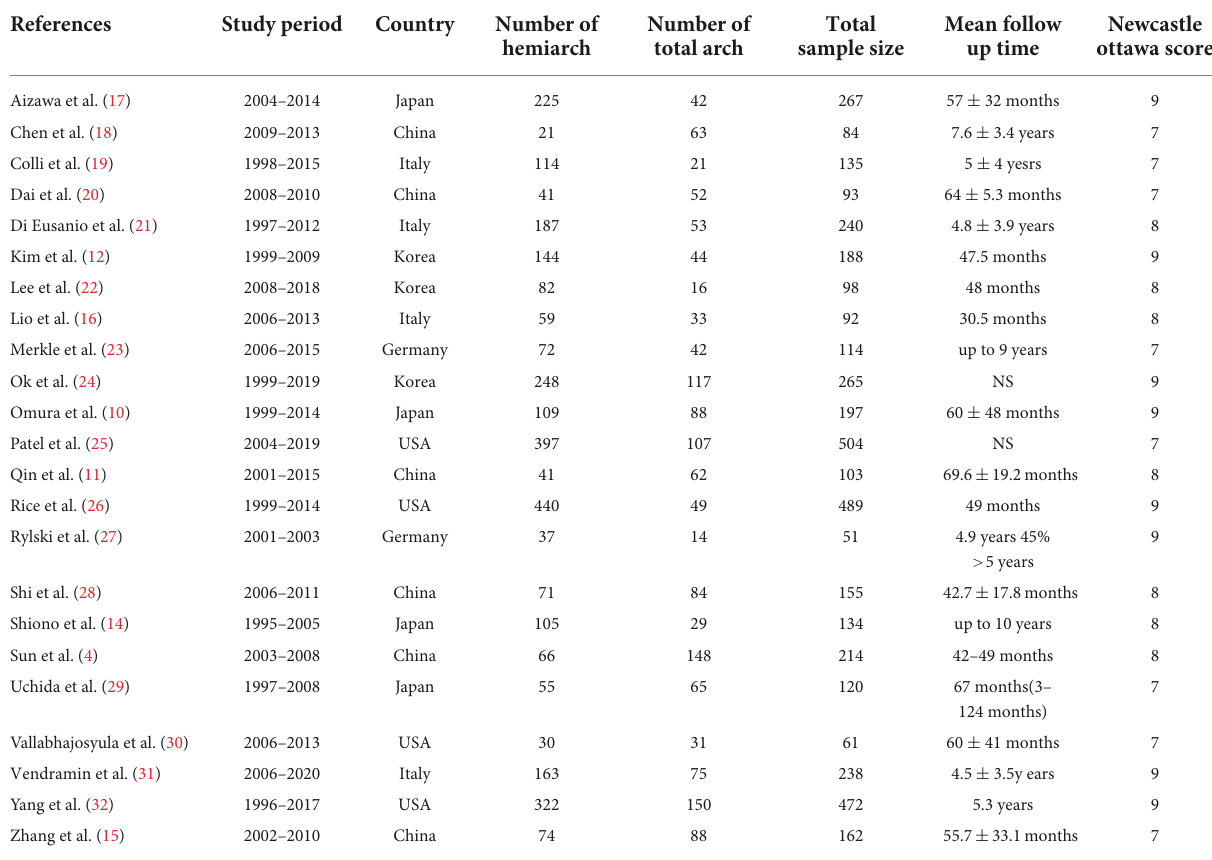
TABLE 1 An overview of publication from selected